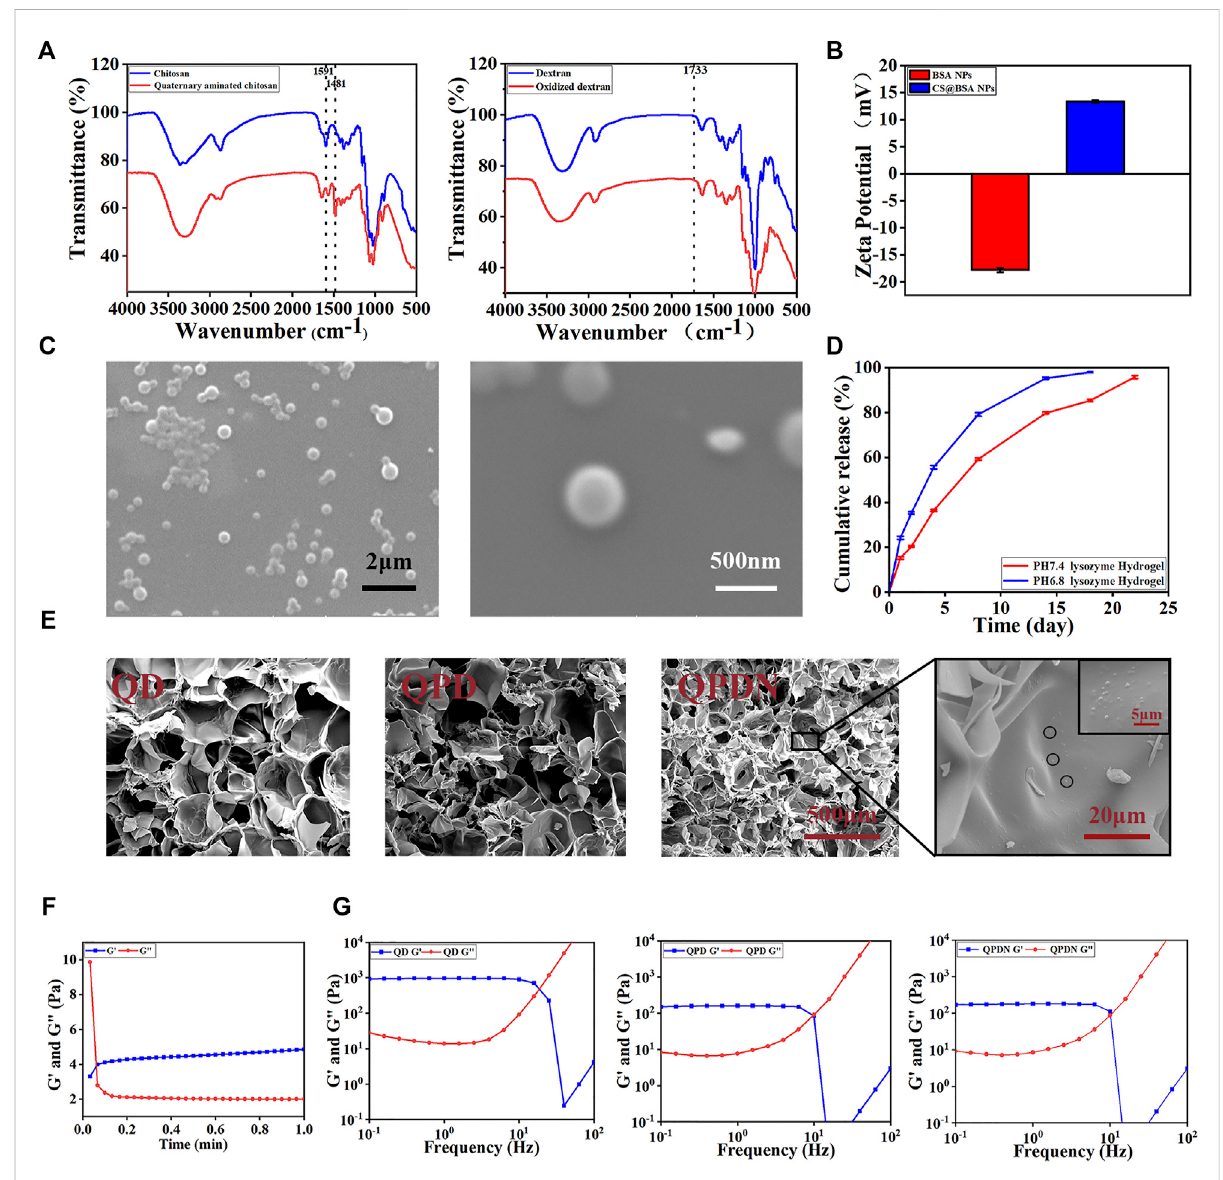
FIGURE 2 Preparation and physical characterization of hydrogels. (A) FTIR spectra of QCS and OD. (B) Zeta potential of the BSA-NPs and CS@BSA-NPs. (C) SEM imageofCS@BSA-NPs, scale bar:2 μ m; 500 nm. (D) Drugrelease from hydrogels inlysozyme solutionsatpH =7.4 andpH =6.8. (E) SEMshows the microstructure of the hydrogel cross-section along with the nanoparticle. Scale bar:500,20, 5 μ m. (F) Gelation time of the QPDN as determined by rheological analysis at 37 ° C. (G) Oscillatory shear rheology of the